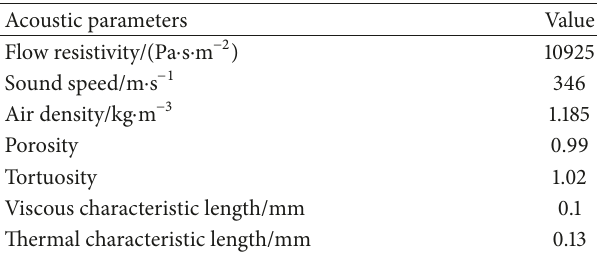
Table 1: Acoustic parameters of